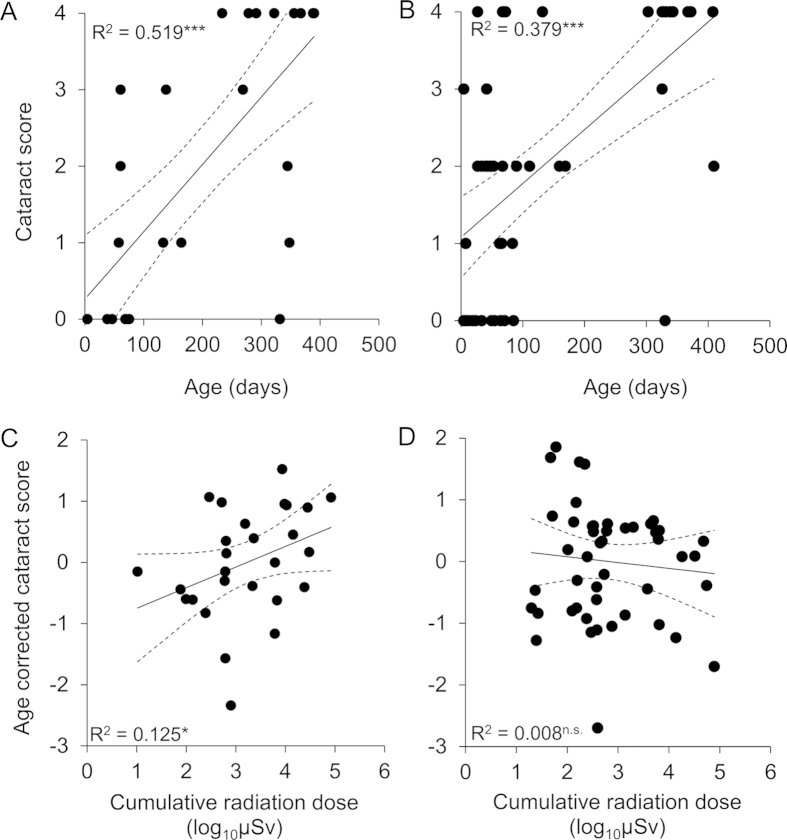
The upper panels show cataract scores regressed against the age estimate for (A) female and (B) male bank voles collected from Chernobyl. The lower panel shows cataract scores corrected for age (standardized residuals from a generalized linear regression on the data split by sex), regressed against the logarithm of lifetime accumulated radiation dose, for (C) female and (D) male bank voles. The symbol after the R2 value denotes the significance level of the regression (n.s. = P > 0.05; *P < 0.05; **P < 0.005; ***P < 0.001). Dashed lines refer to the 95% confidence interval limits of the regression (solid) line.